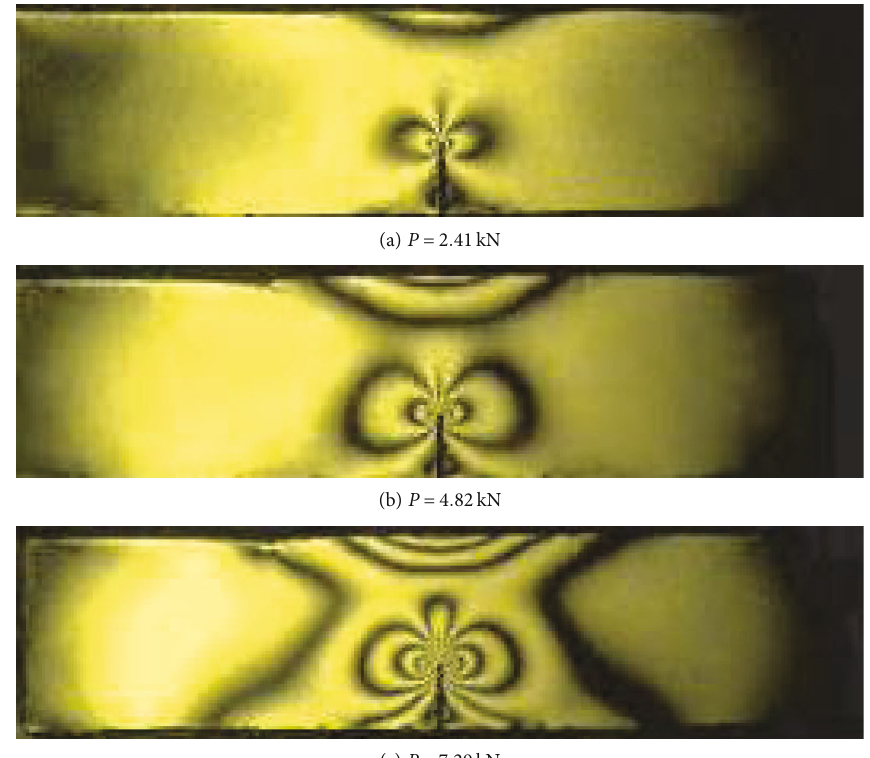
Figure 5: Crack propagation displayed by coatings (specimen